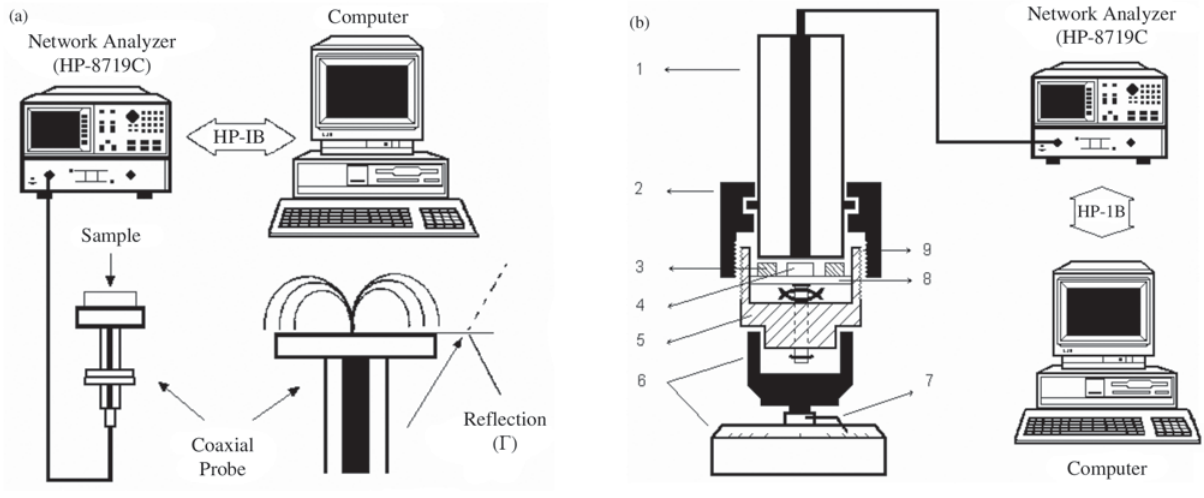
Figure 1. Experimental diagram for dielectric characterization using the reflectometric technique: (a), coaxial probe method and (b), coaxial line method with an adapted moving sample